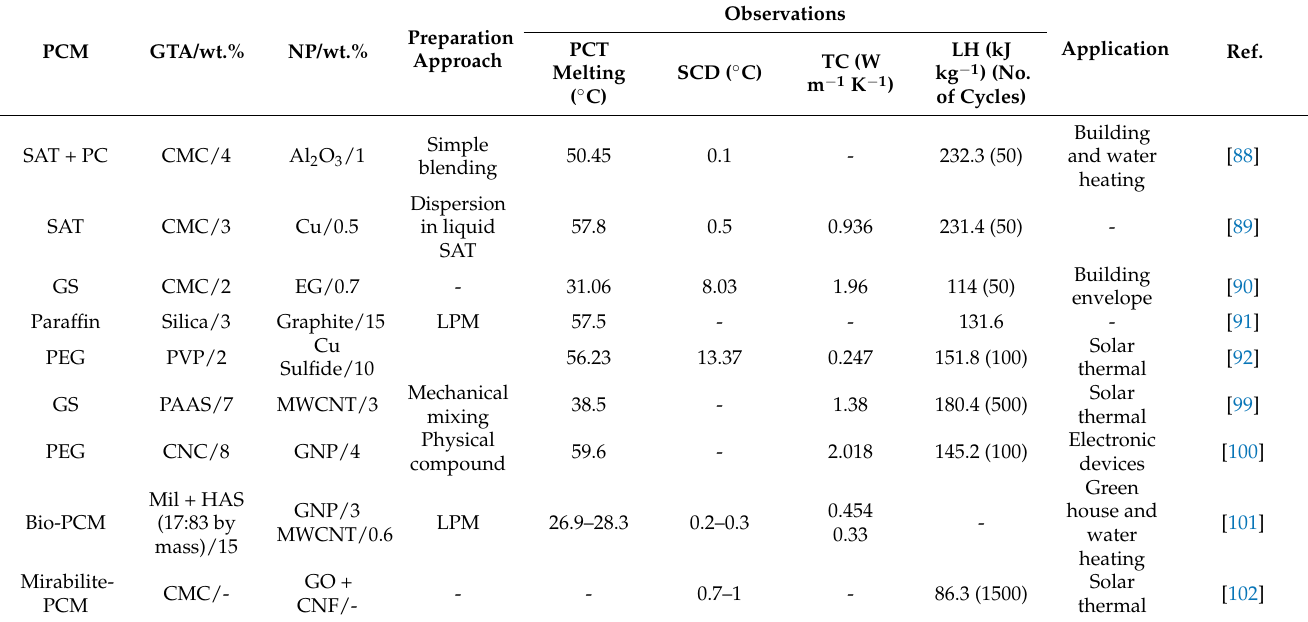
Table 3. Notable observations from the existing PCM + NT+ GTA studies with